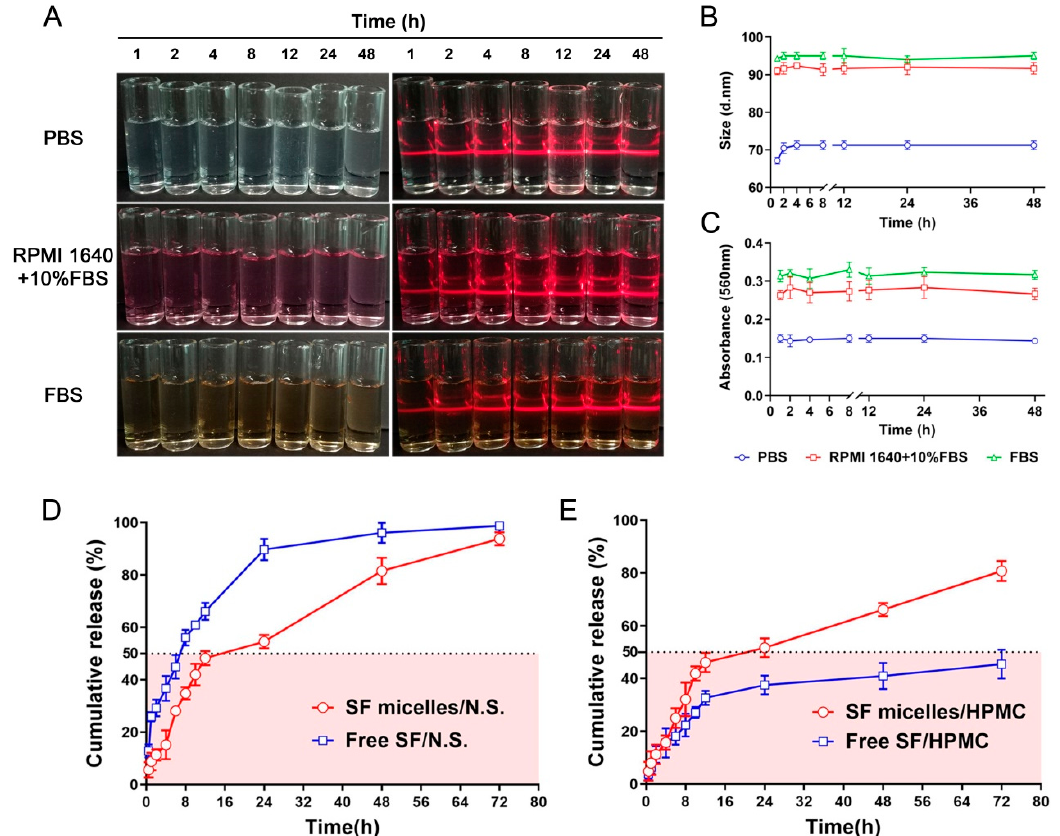
Figure 2. Stability and release profiles of SF micelles. ( A ) Photographs of SF micelles after incubation in different mediums including PBS, RPMI 1640 medium containing 10% FBS and FBS. ( B ) Size change in different mediums measured by DLS. ( C ) Size aggregation in different mediums assessed by absorbance at 560 nm. ( D ) In vitro release of SF micelles dispersed in N.S. and ( E ) HPMC in VFS containing 1% Tween 80 (w/v) at 37 °C (n = 3, mean ± SD).